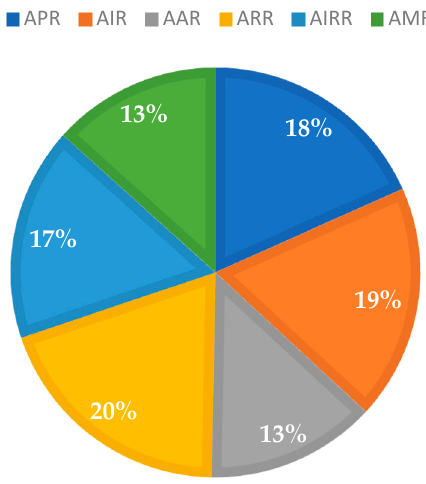
Figure 6. Attributes' importance.